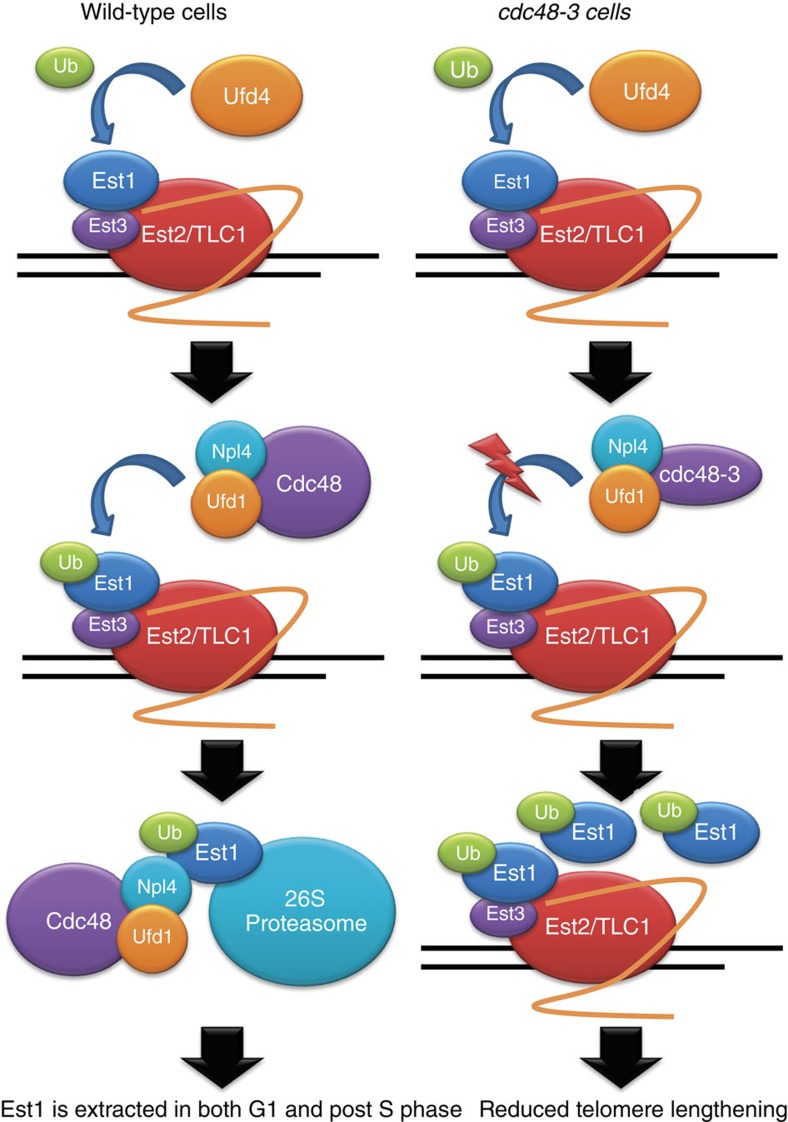
Model for Cdc48-Npl4-Ufd1 regulation of telomerase activity and telomere length.The Cdc48 complex delivers proteins to the proteasome for degradation and Est1 abundance is cell cycle regulated by a proteasome-dependent process. We show that the Cdc48 complex is telomerase associated. We propose that Est1 is ubiquitinated by Ufd4 and this modified form is less capable than unmodified Est1 at fulfilling the activation function of Est1. The Ub binding subunits of the Cdc48 complex recognize and bind Est1-Ub, while Cdc48 catalyses its removal from telomerase, thereby rendering telomerase inactive. We propose that removal can occur in G1 phase to prevent premature assembly of telomerase or in G2/M phase to promote telomerase disassembly. The Cd48 complex brings Est1-Ub to the 26S proteasome, thereby reducing its abundance.